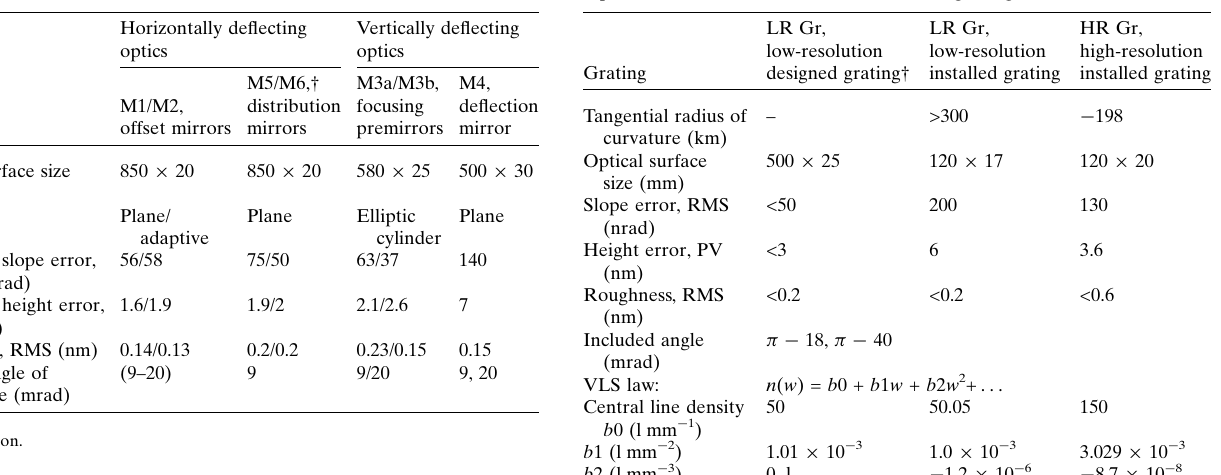
Table 1 Optical elements of the SASE3 beamline: mirrors.